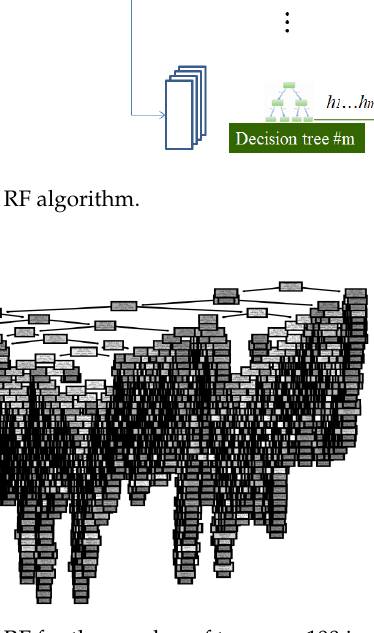
Figure 4. RF for the number of trees n = 100 in our study. 3. Application of Proposed RF Algorithm for Intrusion Detection The proposed NID model combines the ensemble learning RF algorithm and the SMOTE to maintain high precision in prediction stability. The overall structure of the model is presented in Figure 5. The system classifies network traffic in three steps. In Step 1, data preprocessing is performed on the threat data set with the SMOTE scheme; this is done to augment the data of the minority class in the training set to balance the data. The balanced data points are then used for model training, during which the model classifies the potential attacks according to whether they are of normal traffic or malicious behavior. The raw data are analyzed and features are selected using the C4.5 algorithm; the algo- rithm reduces the number of input variables to both reduce the computational cost of the model and accelerate the classification performance of the model. In Step 2, RF ensemble learning is used to train component classifiers and aggregate the results of the component classifiers by randomly selecting subsets of the training data. A metaclassifier is trained with a majority voting approach to perform a threat classification of the observations. In Step 3, the NID model is evaluated in a large-scale network environment using two open- source data sets, UNSW-NB15 [15] and CSE-CIC-IDS2018 [16], on various threats.